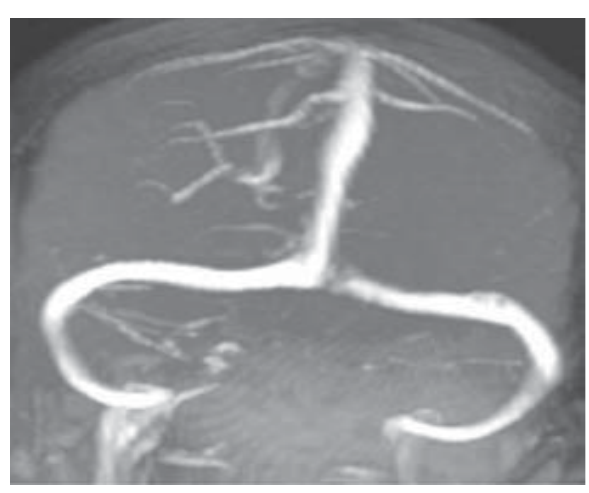
Figure 3. Flow gap in left transverse sinus